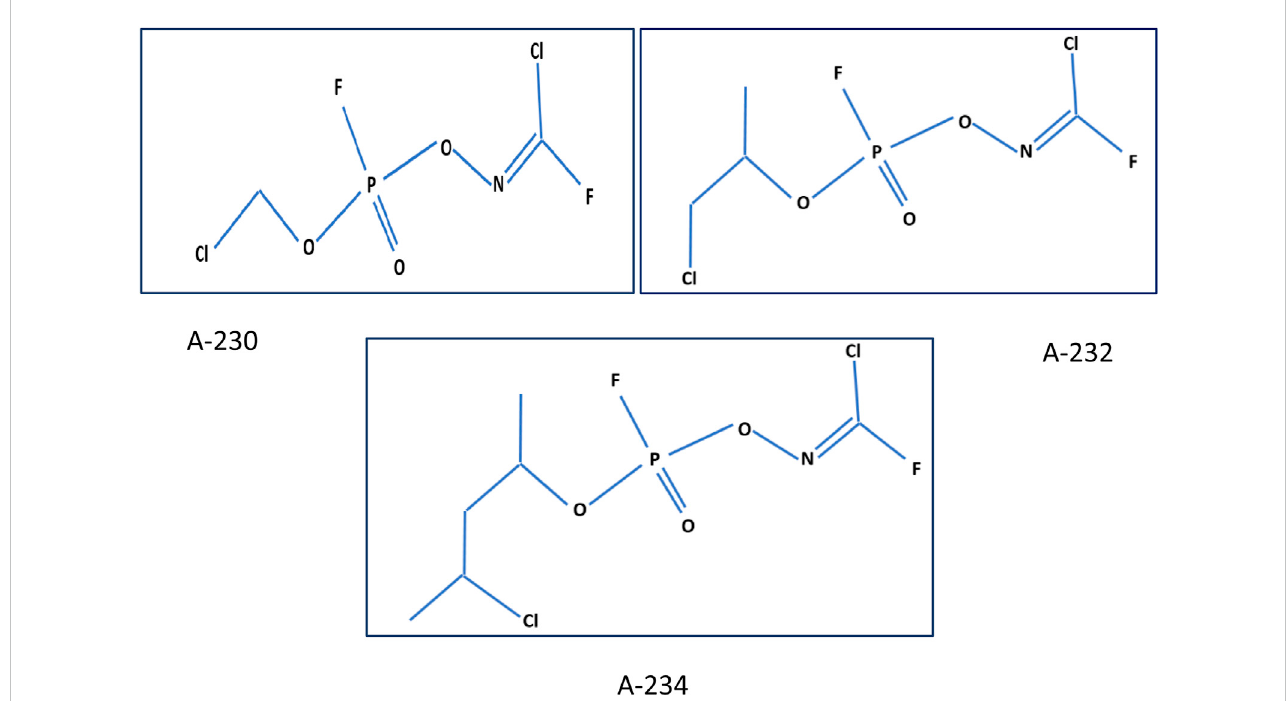
FIGURE 1 Novichok structures (A-230, A-232, A-234) (Kloske and Witkiewicz,